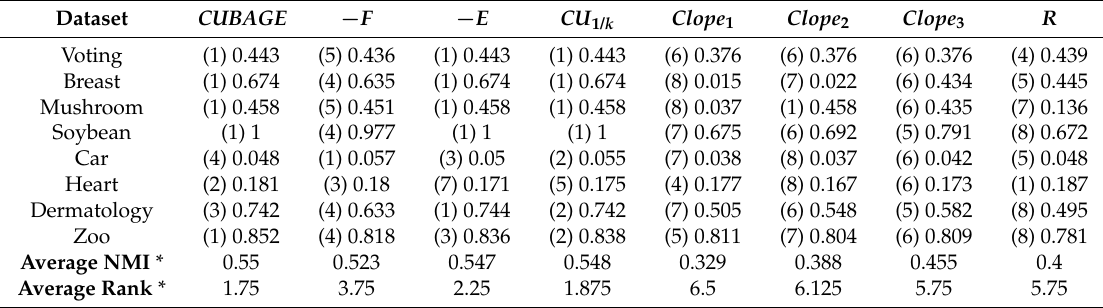
Table 10. Average NMI values of the chosen k -modes partitions over 100 runs ( k fixed to the actual number of classes).